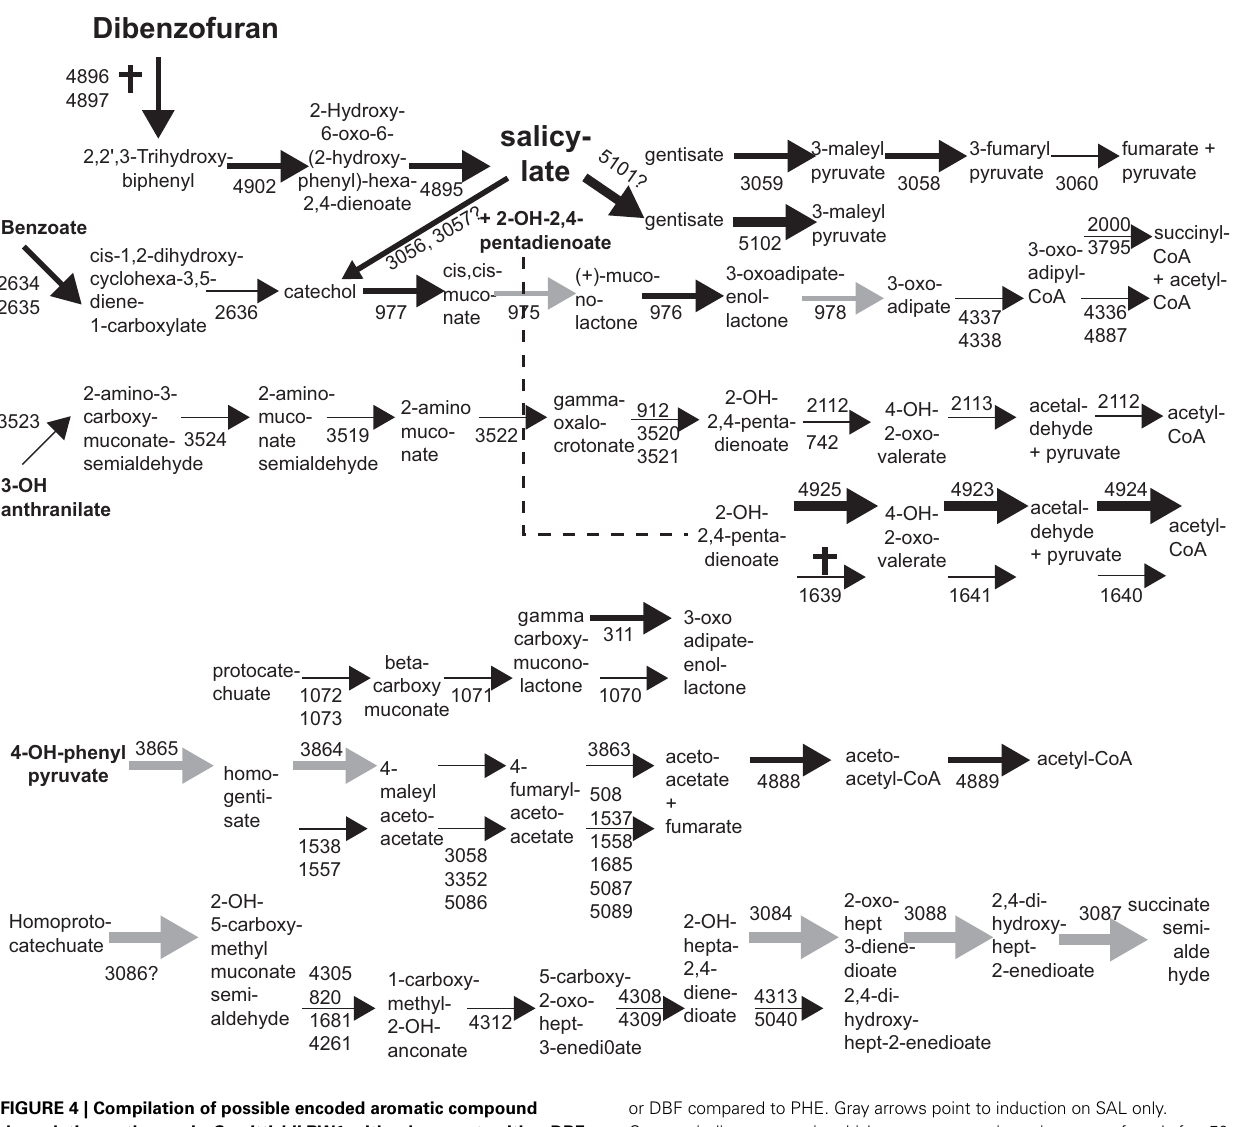
or DBF compared to PHE. Gray arrows point to induction on SAL only. Crosses indicate genes in which no transposon insertions were found after 50 generations growth on DBF. Pathway predictions were done using KEGG and